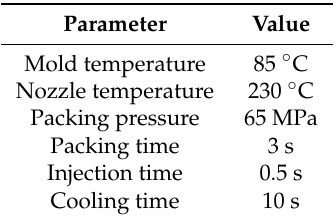
Table 1. Injection molding